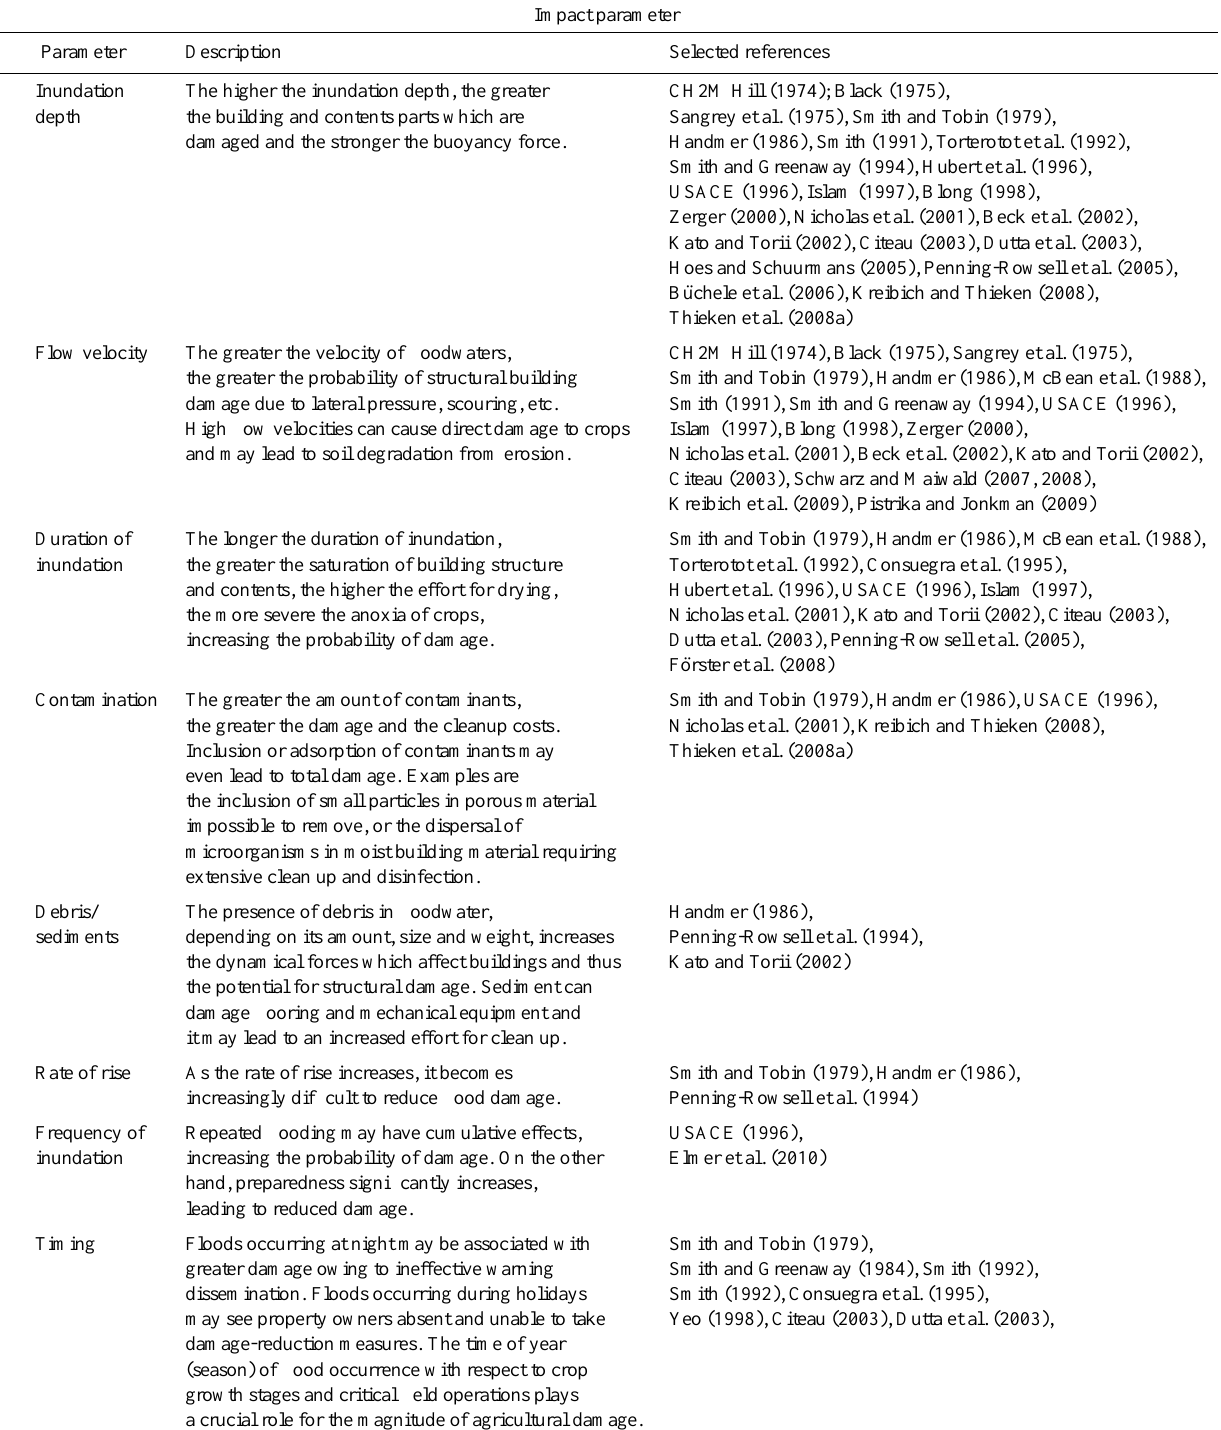
Table 3. Examples of damage influencing factors considered in different flood damage assessments (adapted/extended from Gissing and Blong, 2004; Kelman and Spence, 2004; Merz, 2006; F¨orster et al., 2008).